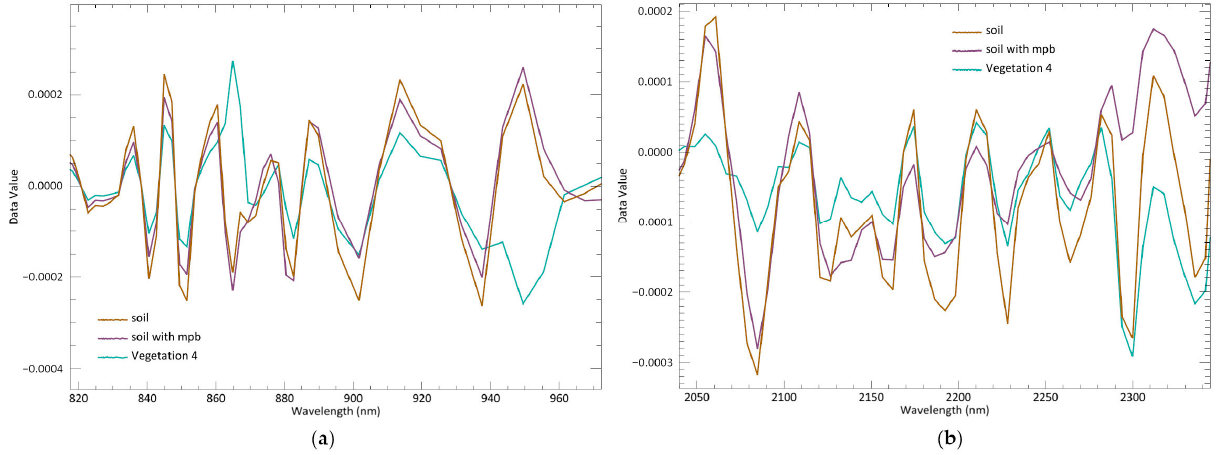
Figure 9. Comparisons of 2nd derivative transformation for the S. maritimus (vegetation 4) and soil